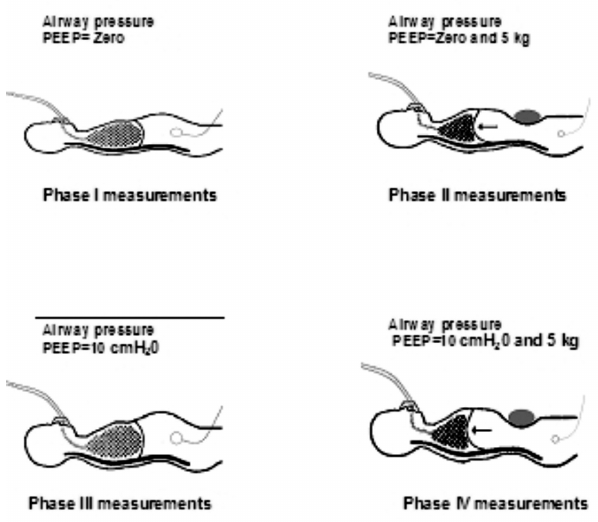
Figure 1 - Different phases of the protocol (I, II, III,